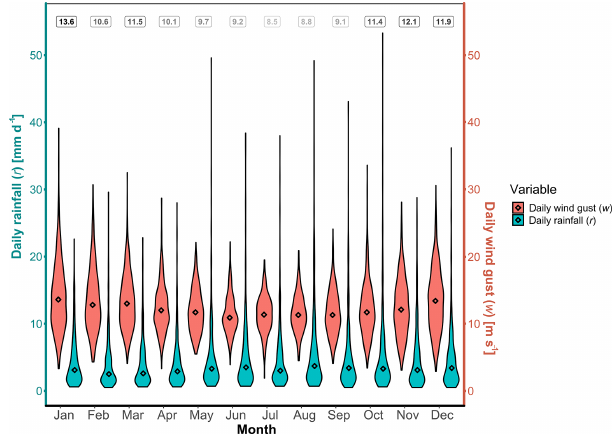
Figure 9. Days where there are recorded both daily wind gust (ms − 1 ) w and non-zero daily rainfall (mmd − 1 ) r> 0mmd − 1 at Heathrow Airport (London, UK) for the period 1971–2018. Daily rainfall data from E-OBS (Cornes et al., 2018) and wind gust data (the maximum 3s wind velocity in a day) from the Met Of- fice (2019). Colours (legend) represent the bivariate density esti- mated from a kernel density estimator with higher values and lighter colours representing a higher density of points at that bivariate value ( r , w